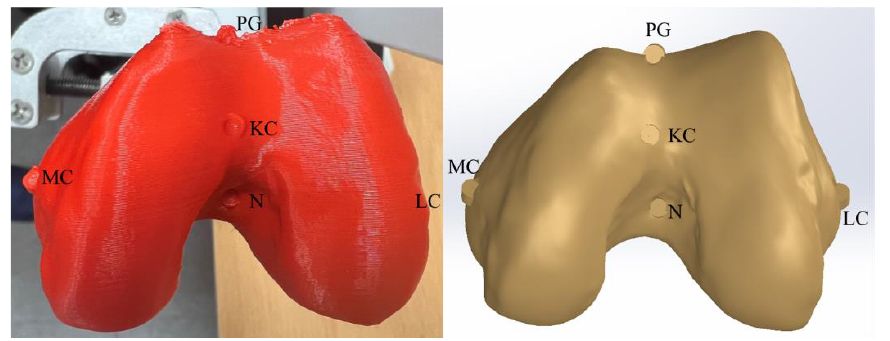
Figure 6. Printed bone model and CAD bone model.